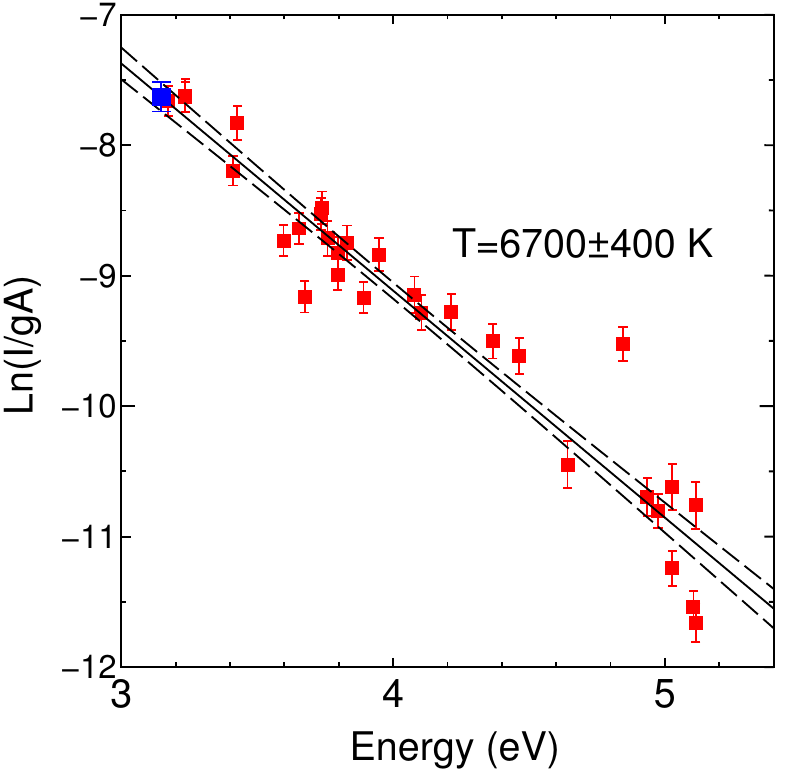
Figure 3. Boltzmann plot obtained using the present experimental line intensity I and the gA values taken from Lawler2008 [10] (red squares). The fitted linear function and the 68.3% confidential interval are shown in the solid and dashed lines, respectively. The blue square represents the linear function value at 3.147 eV for obtaining the A value of the 393.863 nm line (see text for